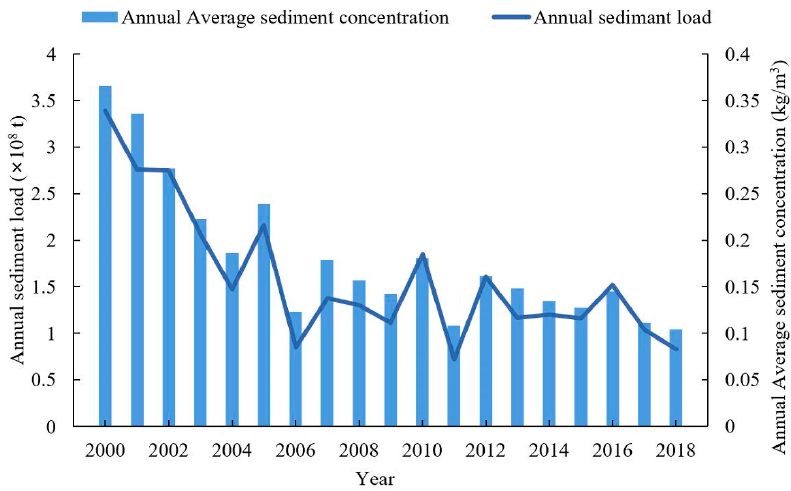
Figure 10. Annual average sediment concentration and sediment load of Yangtze River from 2000 to 2018. Data were collected from Yangtze River sediment bulletin of Datong gauging station.